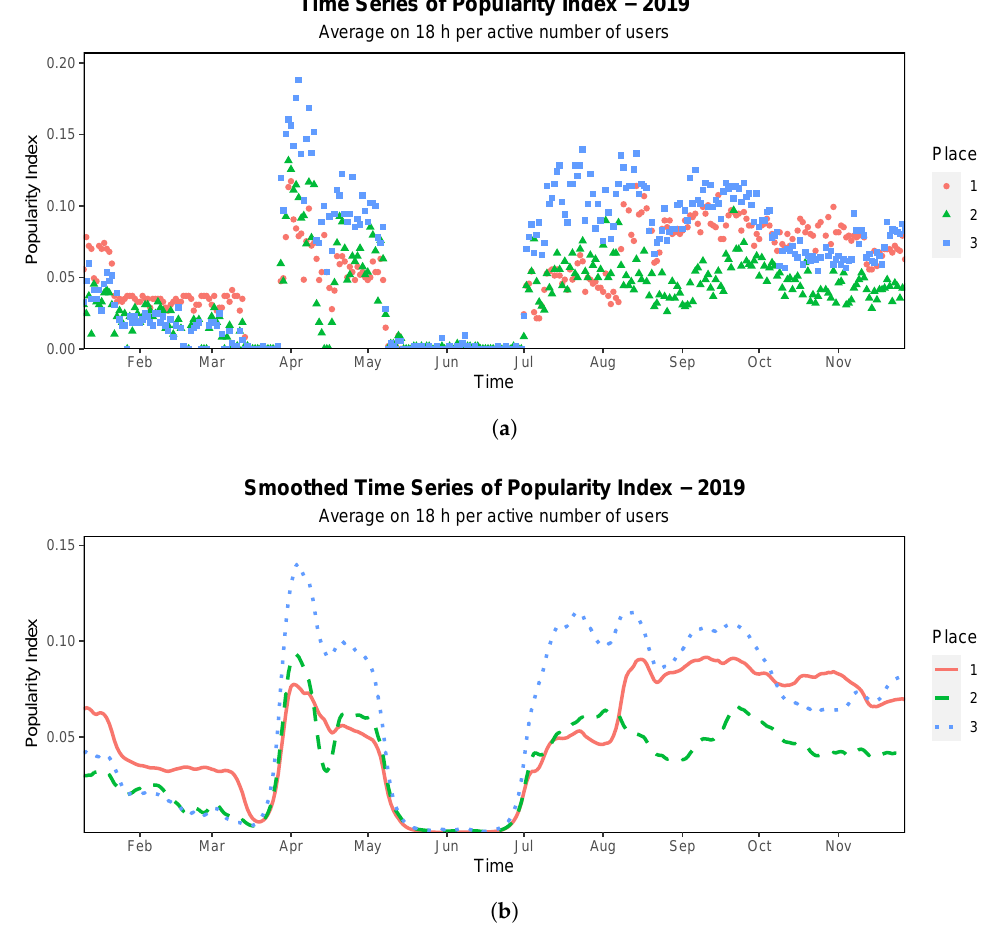
Figure 3. Comparison between computed and smoothed times series of the Popularity Index ( PI ). ( a ) Before Smoothing. ( b ) After